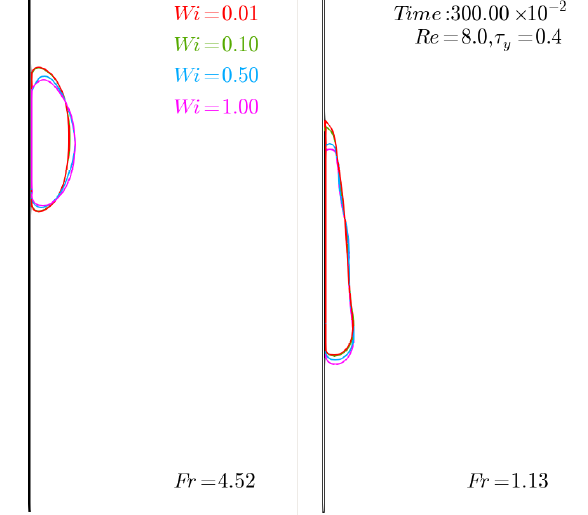
Figure 9. Collision of drops on a vertical wall for fixed values of the Reynolds, Re = 8, and plastic numbers, τ y = 0.4 and the following values of the Weissenberg number, Wi = { 0.01;0.1;0.5;1 } . ( left column ) Fr = 4.52; ( right column ) Fr = 1.13. Dimensionless time, t =